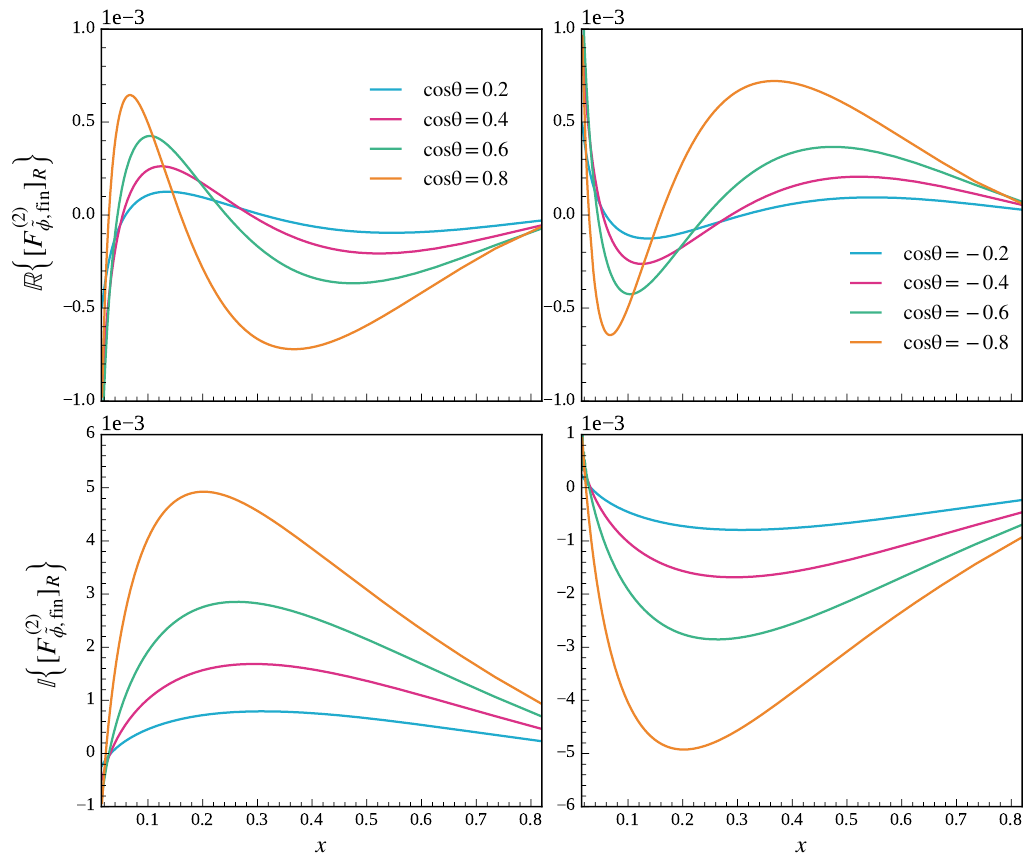
Figure 5. Behaviour of real (upper panel) and imaginary parts (lower panel) of two-loop UV renormalised finite remainder function of the scaling variable x for positive (left panel) and negative (right panel) values of cos( θ )